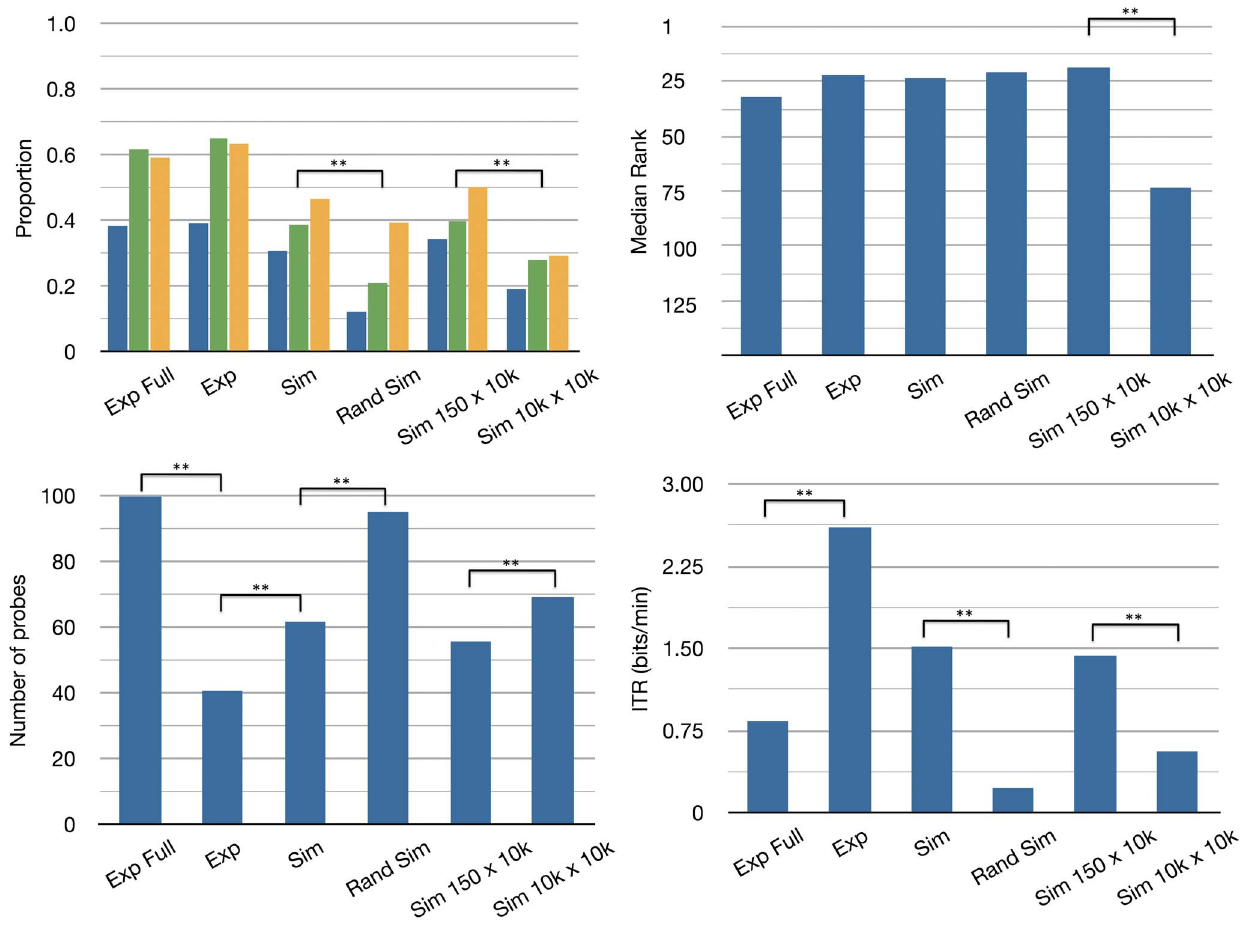
Figure 7. Post-hoc simulations. Results for post-hoc simulations: Exp Full: the experiment using the full number of probes, Exp: results from the experiment with early stopping, Sim: simulation results with early stopping, Rand Sim: simulation with random probe selection and early stopping, Sim 150 6 10k: simulation with 150 targets and 10.000 probes with early stopping, Sim 10k 6 10k: simulation with 10.000 targets and 10.000 probes with early stopping. Top-left: Proportion correct, related correct and in top 10. Top-right: Rank, the rank for the last analysis (Sim 10k 6 10k) is scaled by dividing by 61.8. Bottom-left: Number of probes. Bottom-right: Information Transfer Rate. * indicates .001 , p , .05, ** indicates p , .001.